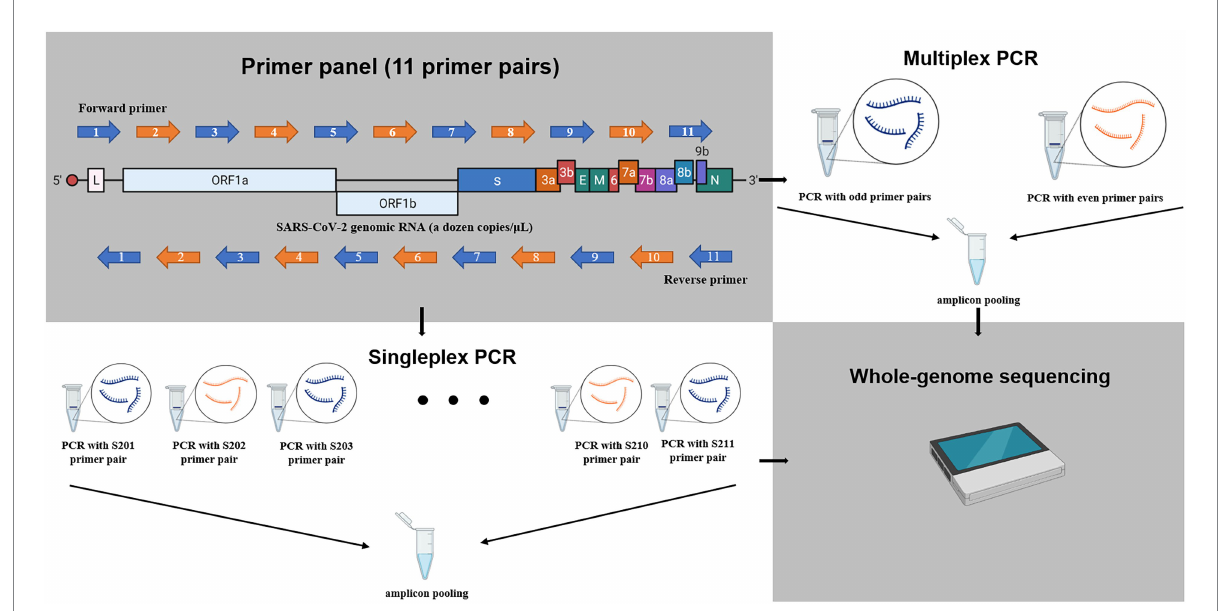
FIGURE 1 The schematic diagram for amplification of SARS-CoV-2 RNAs in this study. The whole genome of SARS-CoV-2 was amplified to 11 amplicons of approximately 3 kb using 11 primer panel. The blue and orange arrow indicates odd primer pair or even primer pair, respectively. Singleplex: the 11 amplicons were amplified with 11 individual reaction mixtures and pooled. Multiplex: the 11 amplicons were amplified with two reactions mixtures (six odd-numbered primer pairs and five even-numbered prime pairs) and then pooled. The schematic figure was drawn with